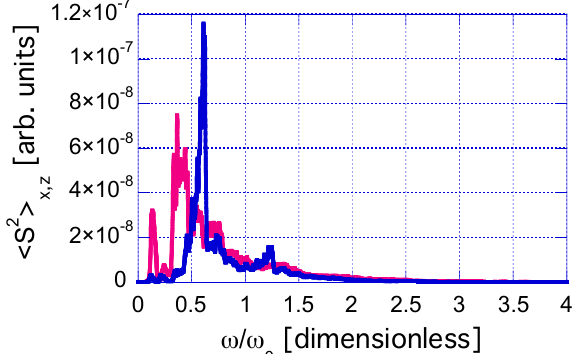
Figure 10. Averaged TS spectrum computed for a sample of 1024 trapped trajectories whose initial conditions are generated randomly in a circle of radius w 0 /20 around the laser beam axis. Averaged spectrum along x -axis is plotted in red, along z -axis in blue. Spectrum shows an overall shift towards lower frequencies in this case as compared with case study 1, and a more balanced contribution of its x and z